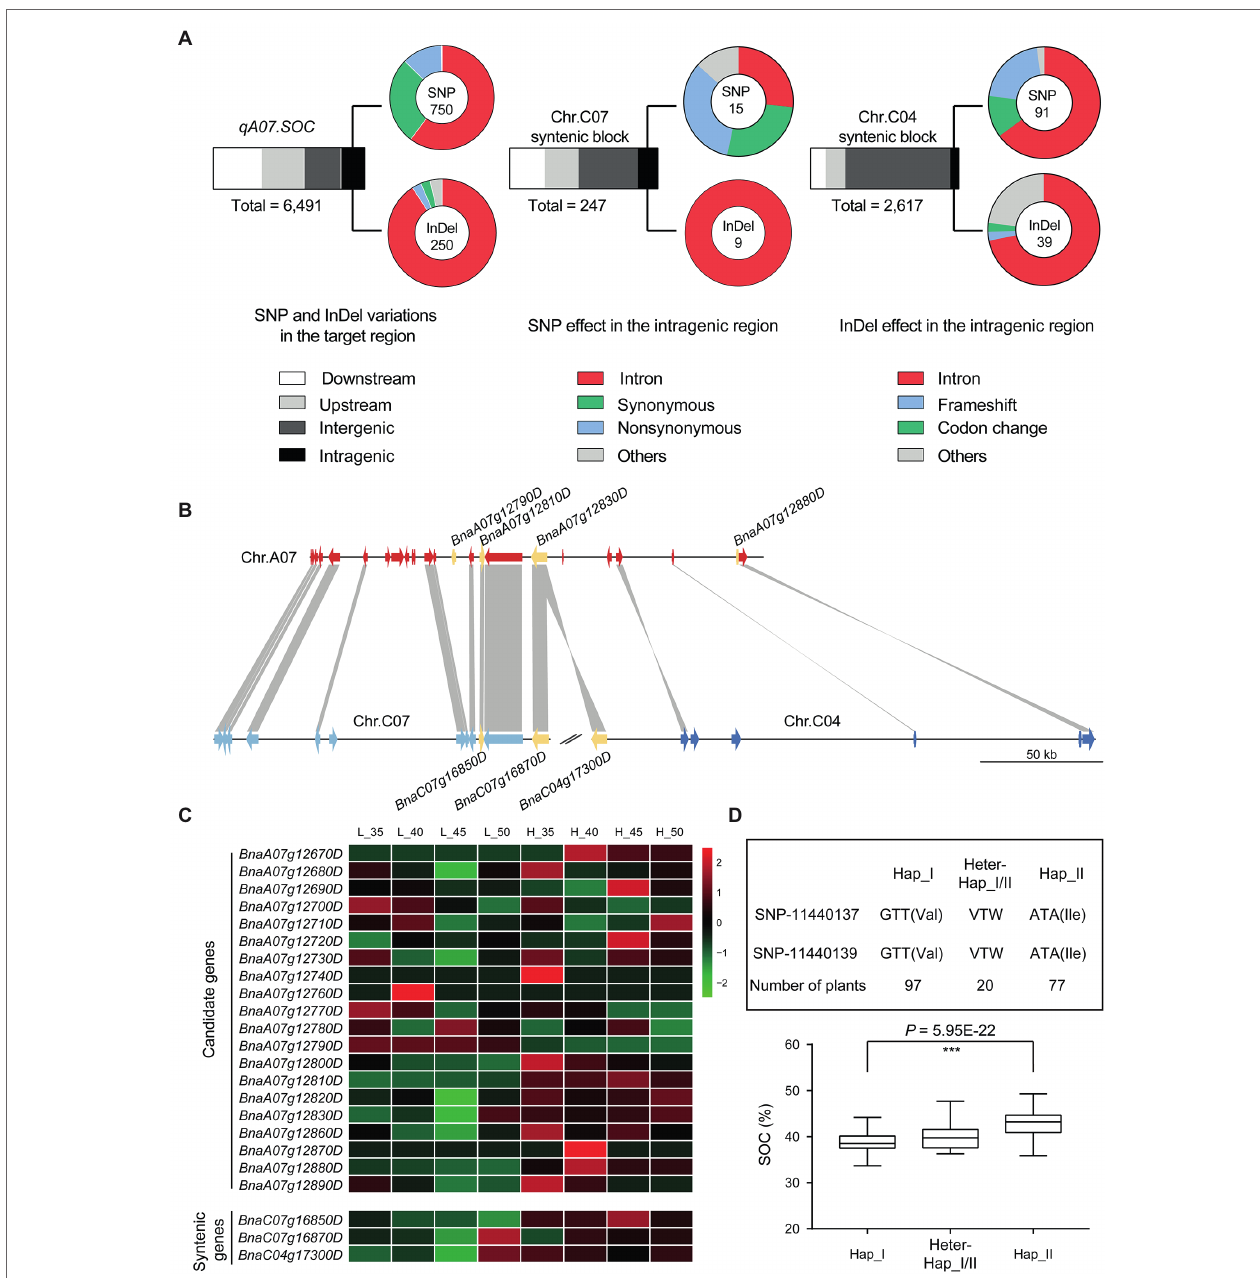
FIGURE 6 | The candidate genes prediction by comparative analysis. (A) The variations were identified in qA07.SOC and the syntenic regions. (B) The syntenic analysis for qA07.SOC . (C) Heatmap displays the expression levels of the candidate genes and the syntenic genes. The bars represented FPKM normalized transformed counts. (D) Haplotype analysis based on GWAS in